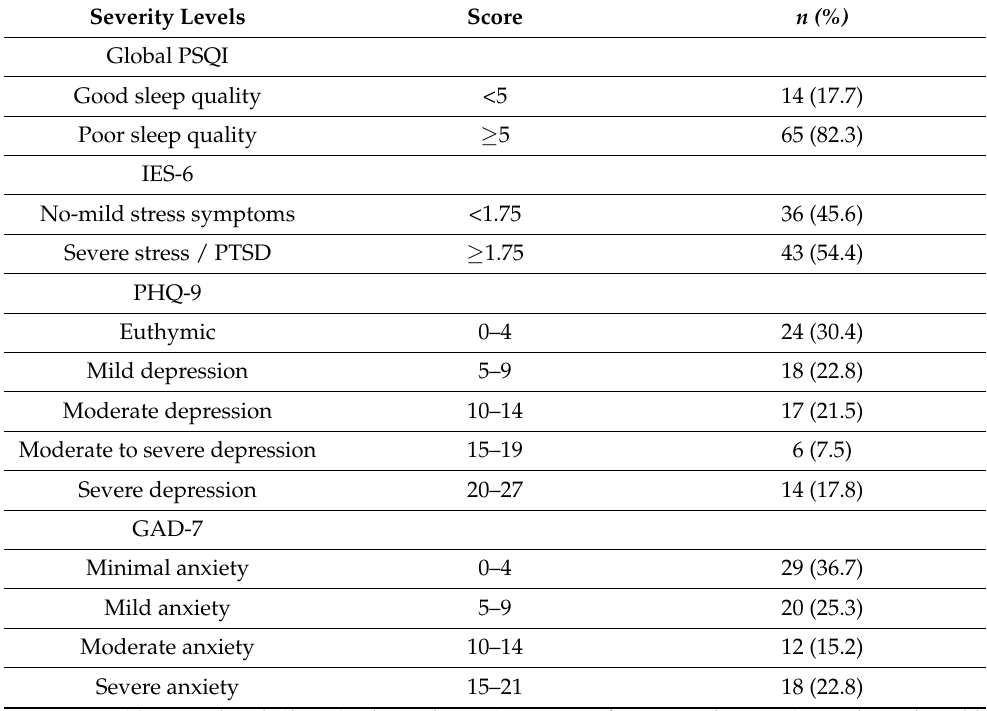
Table 3. Clinical cut-off frequencies.